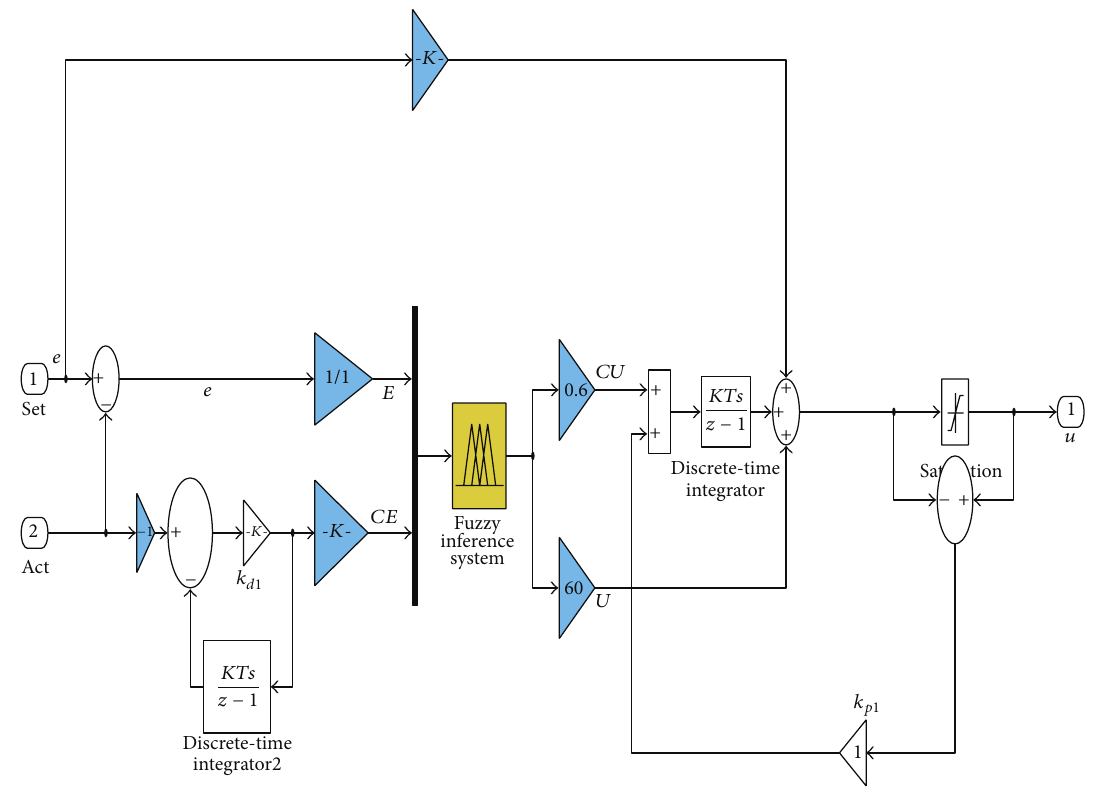
Figure 6: Fuzzy-PID controller for BLDC motor drive.